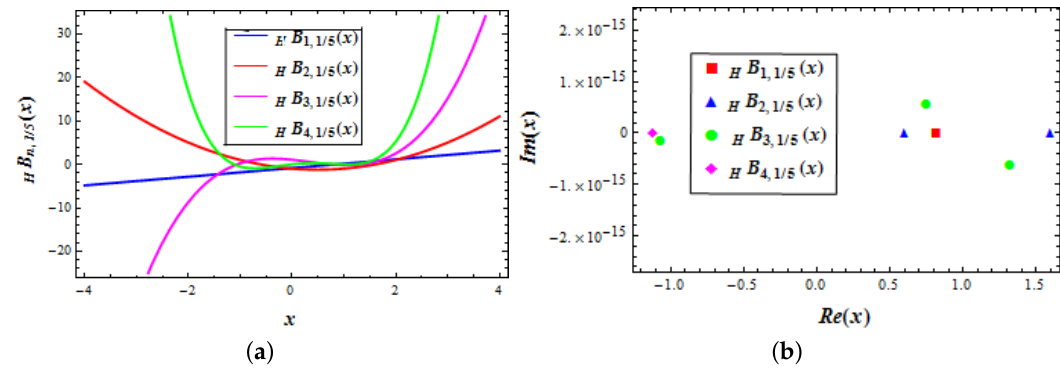
Figure A1. ( a ) Shape of H B n ,1/5 ( x ) ; ( b ) Zeros of H B n ,1/5 ( x )